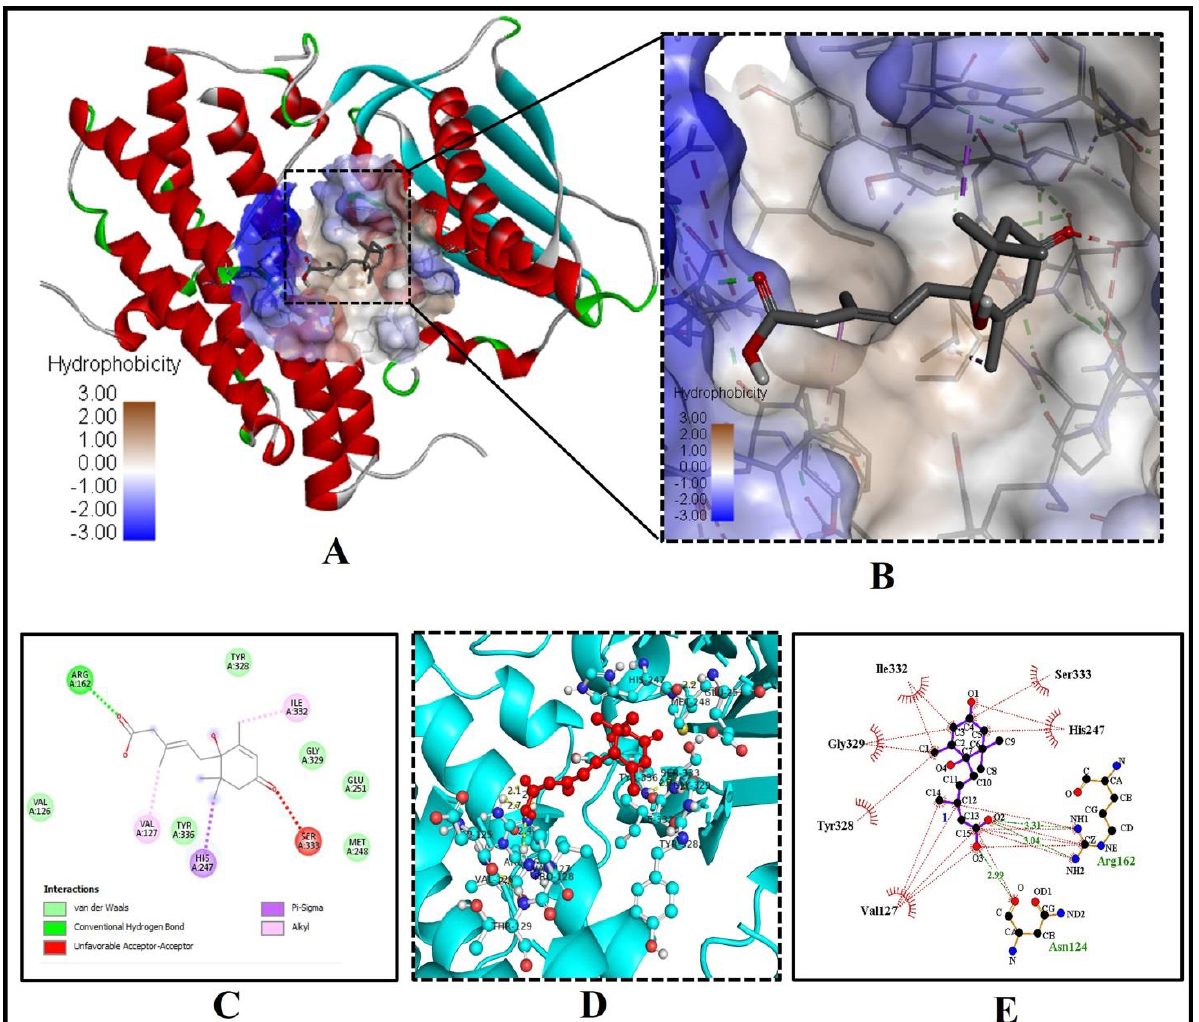
Figure 9. The docked complex of ABA with human pyruvate dehydrogenase kinase (PDB ID: 4MP2). ( A ) ABA binds with the catalytic site. ( B ) Magnified view showing the hydrophobicity of the amino acid fragments of the binding cavity ( C ) 2D graph showing the interactions at the molecular level of the bound cavity fragments with the inhibitor ABA. ( D ) The 3D image is showing interactions (with bond length) of ABA (red ball and sticks) with residues of human PKD (cyan ball and sticks). ( E ) 2D LigPlot is showing atomic level interactions of vesicle fragments of pyruvate dehydrogenase kinase bound to ABA.